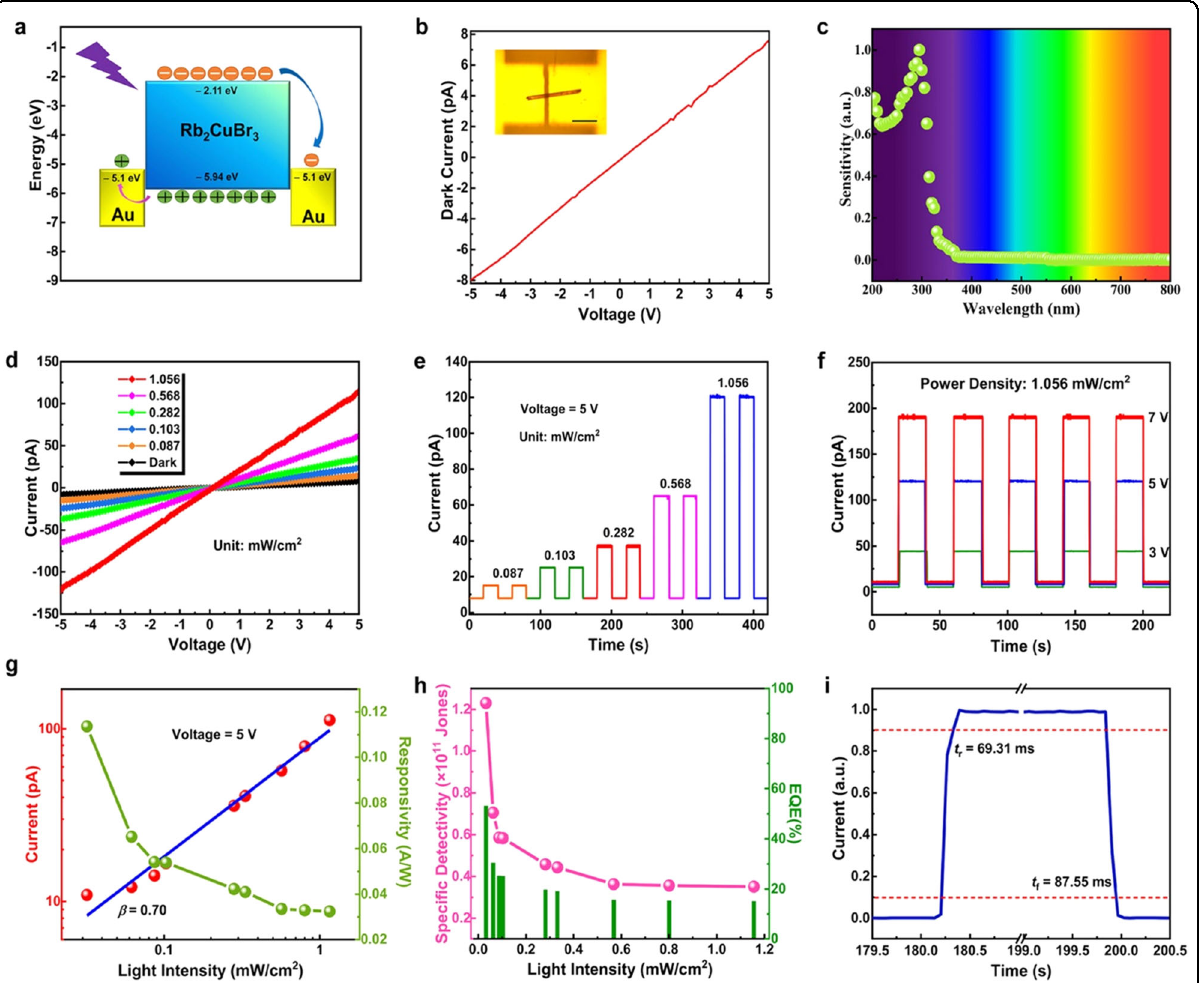
Fig. 13 PDs based on 1D Rb 2 CuBr 3 microwires. a Schematic presentation of the band alignment for the proposed PDs based on Rb 2 CuBr 3 microwires. b Typical I − V curve measured in the dark. c Spectral response of the Rb 2 CuBr 3 microwire photodetector. d I − V curves in the dark and under different light conditions (265 nm, 5 V). I − t curves for PDs operated at different e light intensities and f bias voltages. g Logarithmic plot of the photocurrents (blue line) and photoresponsivities (green line) of the PDs versus the light intensity. h Plots of detectivity and EQE for the photodetector versus the light intensity. i One response cycle of the I − t curve for a PD operated at 5 V. Reproduced with permission from ref. 143 . Copyright 2021 American Chemical